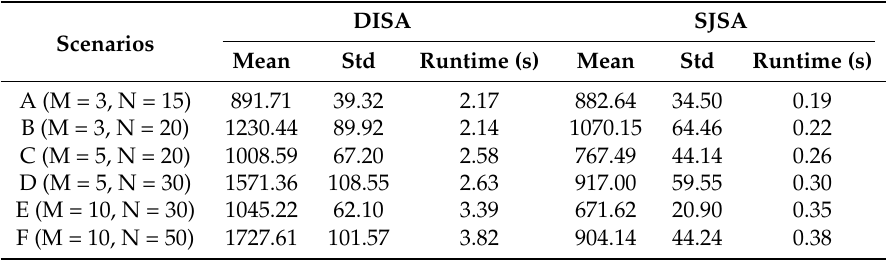
Table 3. Performance comparison of Delete-and-Insert Simulated Annealing (DISA) and Swap-and-Judge Simulated Annealing (SJSA).